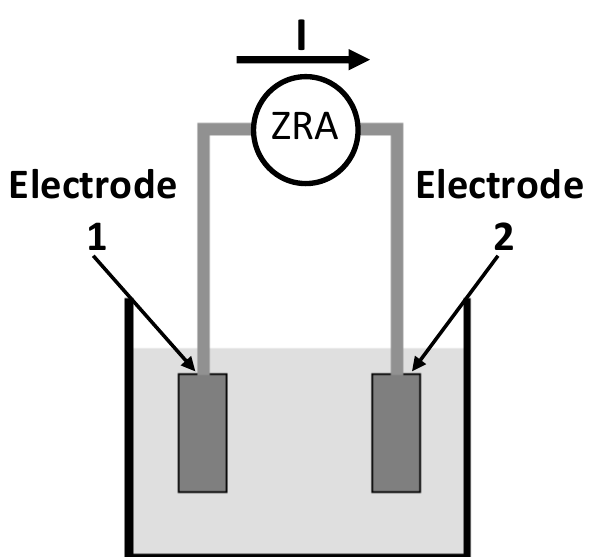
Figure 10. Schematic of the experimental setup for EN measurements. Reproduced with permission from ref. [122]. Copyright 2007 Wiley.